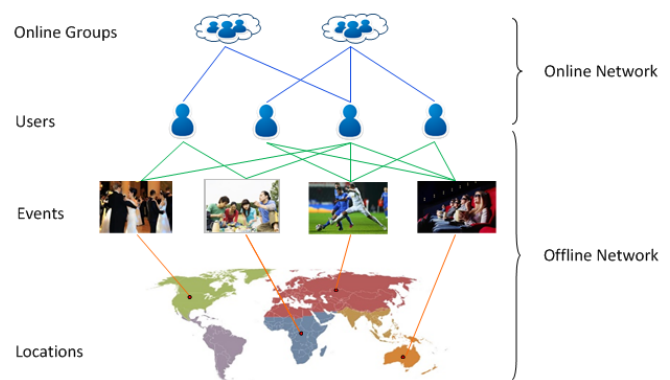
Figure 1. Structure of an event-based social network